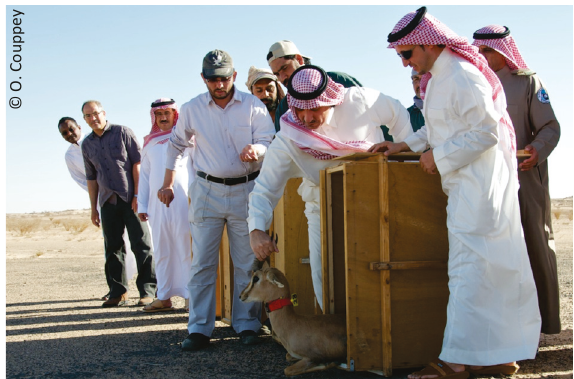
m l a I s u l r - f a Z a M . © Image 2. Arabian Mountain Gazelles with collars males and a female